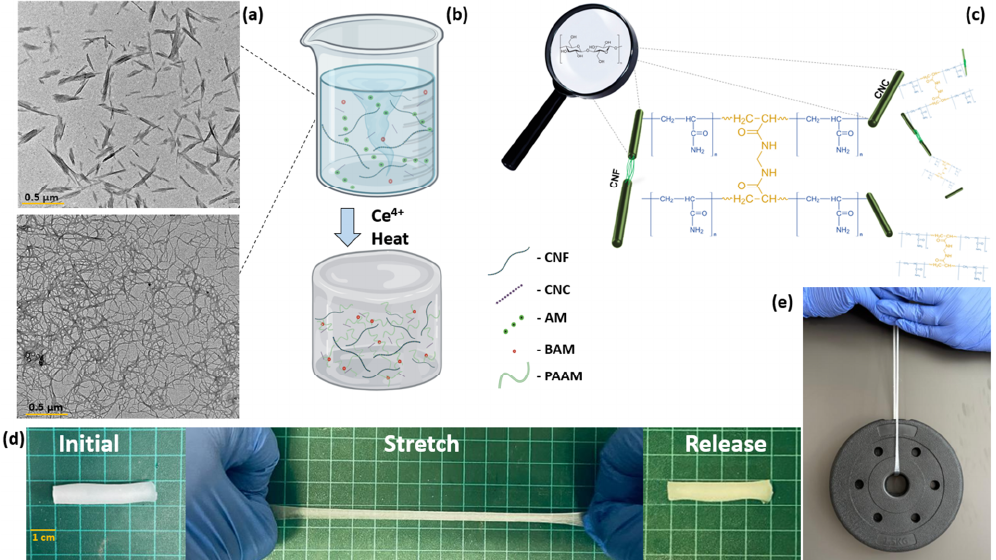
Figure 2. Schematic hydrogel fabrication overview and properties. ( a ) Transmission electron micro- scope (TEM) micrographs of CNC and CNF (reproduced with permission form copyright owner). ( b ) Experimental overview of hydrogel fabrication. ( c ) Proposed microstructure of polyacrylamide complexes grafted onto CNC and CNF particles crosslinked by N,N’-methylene bisacrylamide. ( d ) Photographs depicting the stretchability of fabricated hydrogels. ( e ) Photograph of a 1.5 kg weight held by the hydrogel sample.